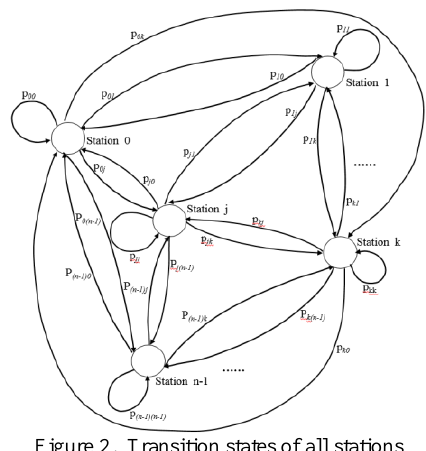
Figure 2. Transition states of all